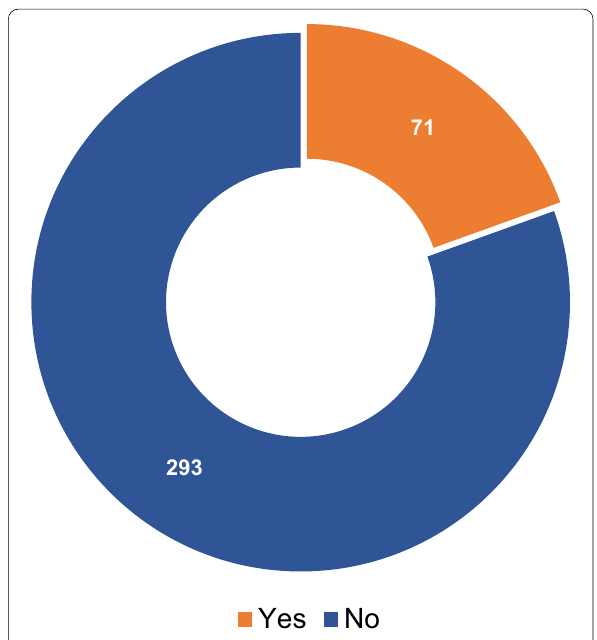
Fig. 10 Respondents previously familiar with the concept of value-based healthcare (VBH)/value-based radiology (VBR)